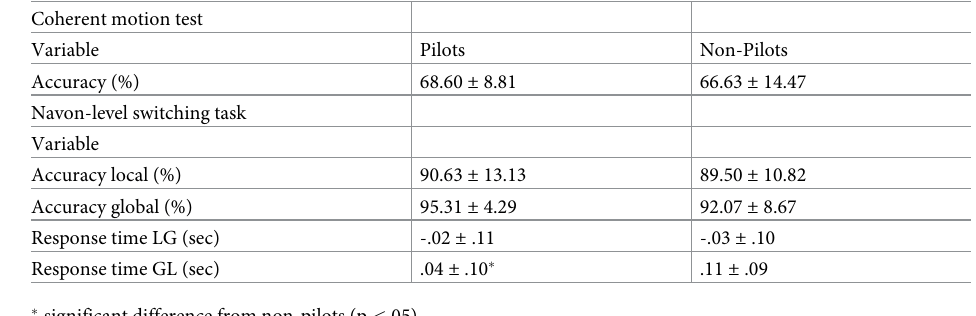
Table 2. Generic task performance in pilots and non-pilots: Coherent motion detection accuracy, local detection accuracy, global detection accuracy, response time difference between local (L) and global (G) detection and vice- versa (mean ±